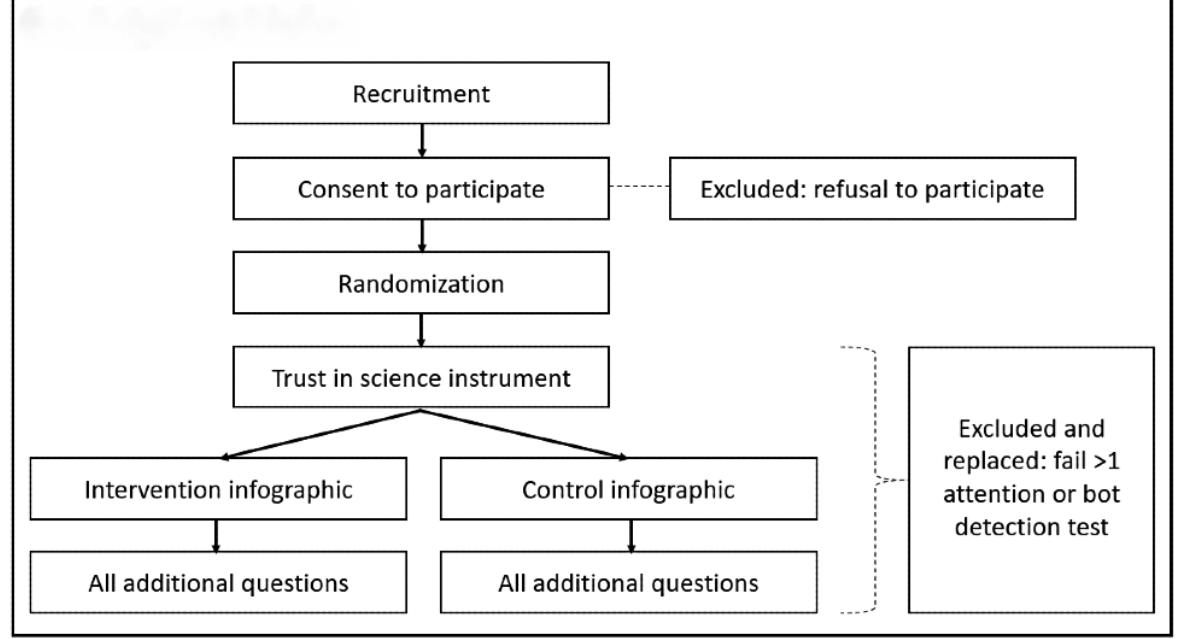
Figure 2. Study design and